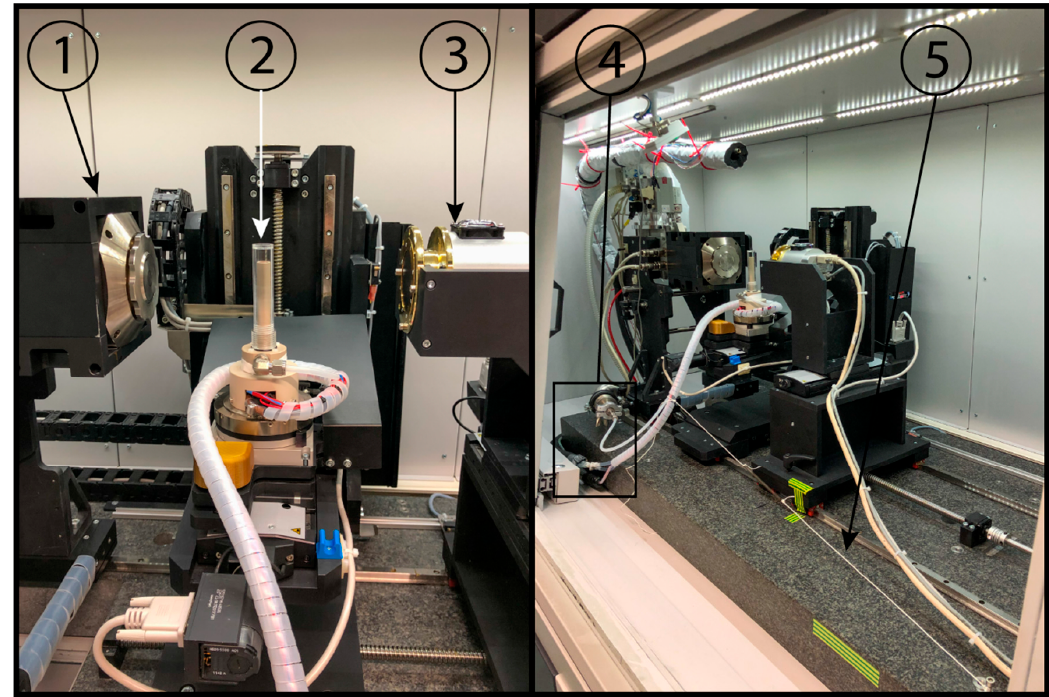
Figure 1. In-house XCT-1600 HR µ -CT; ( 1 ) X-ray tube; ( 2 ) Fixed freeze-drying stage; ( 3 ) CCD-11000XR detector; ( 4 ) Stage-Connection; ( 5 ) Winding support.